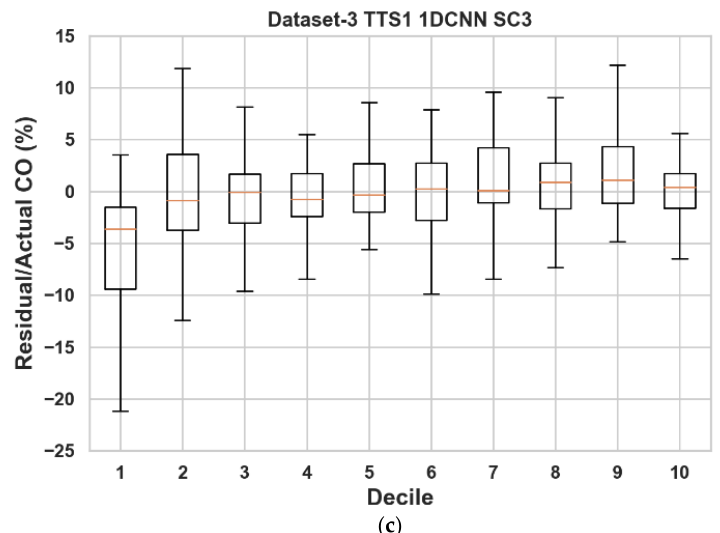
Figure 7. Box plots of residuals from the 1DCNN algorithm as a percentage of reference CO for TTS1 (90/10) with all available input parameters (SC3). ( a ) Datasets 1. ( b ) Datasets 2. ( c ) Datasets 3.